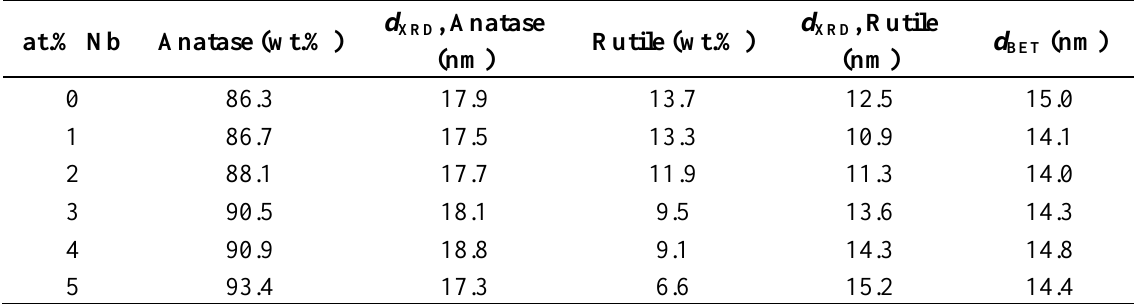
Table 2. The relative amounts of anatase, rutile and their crystallite sizes calculated from the XRD data using the Rietveld method and BET average primary particle size of undoped TiO and Nb-doped TiO FSP samples. 2 2 at.%